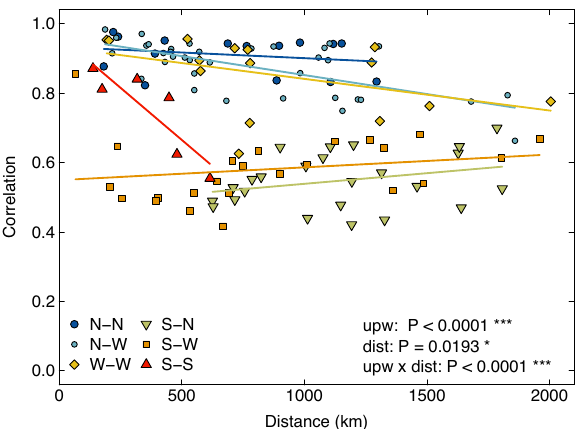
Figure 4. Pairwise correlation in temperature between sites as a function of their geographical distance. Data points are coded by color and shape based on each paired sites’ upwelling condition combination. Strong upwelling pairs (S–S) are represented in red triangles, Strong–Weak upwelling pairs (S–W) are represented in orange squares, Weak upwelling pairs (W–W) are represented in yellow diamonds, No–Weak upwelling pairs (N–W) are represented in small light blue circles, No upwelling pairs (N–N) are represented in large dark blue circles, and Strong-No upwelling pairs (S–N) are represented in green inverted triangles. P -values are based on ANCOVA relating average pairwise correlation in temperature between sites to their upwelling condition and geographical